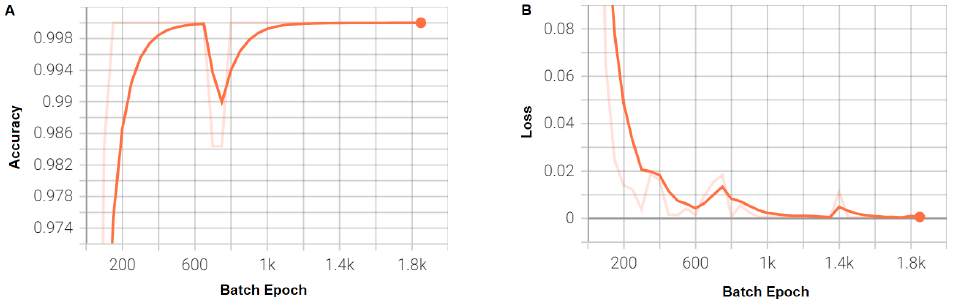
Figure 5. ( A ) Training accuracy. ( B ) Training loss. Table 4. Experiments with different combinations of spectral bands and vegetation indices and their classification